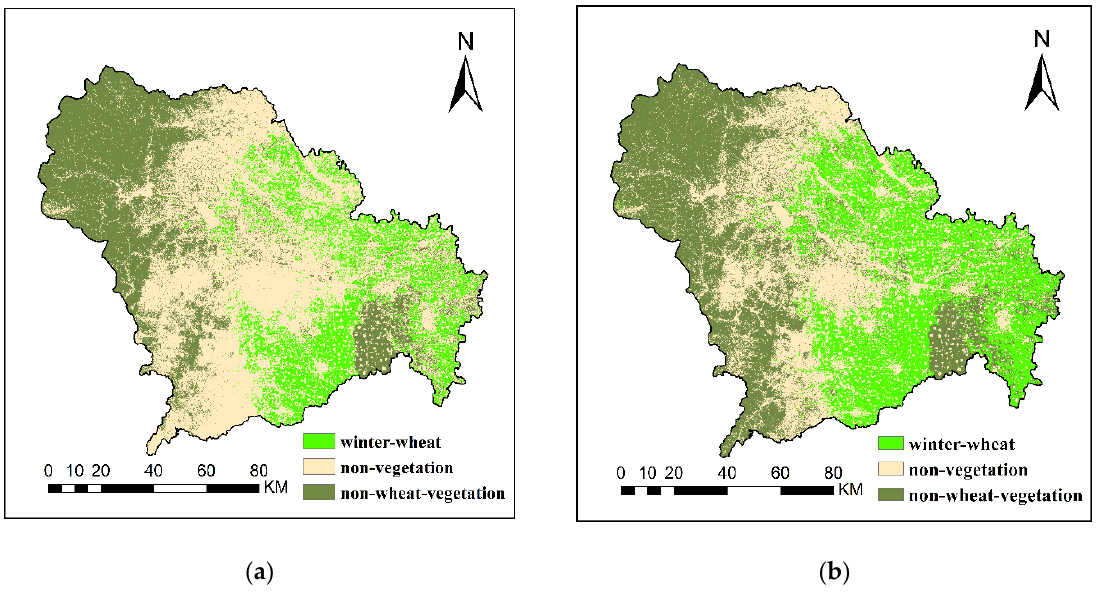
Figure 7. ( a ) Distribution of winter wheat in Shijiazhuang, based on Landsat 8 extraction for 2018. ( b ) Distribution of winter wheat in Shijiazhuang, based on Landsat 8 extraction for 2019.